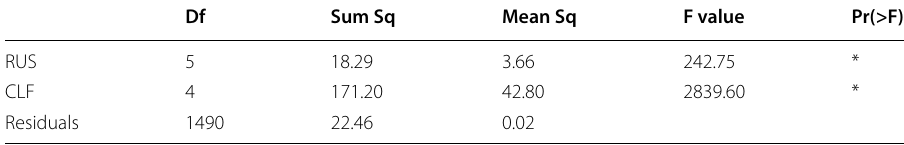
*Indicates the values is less than 1 × 10 − 4